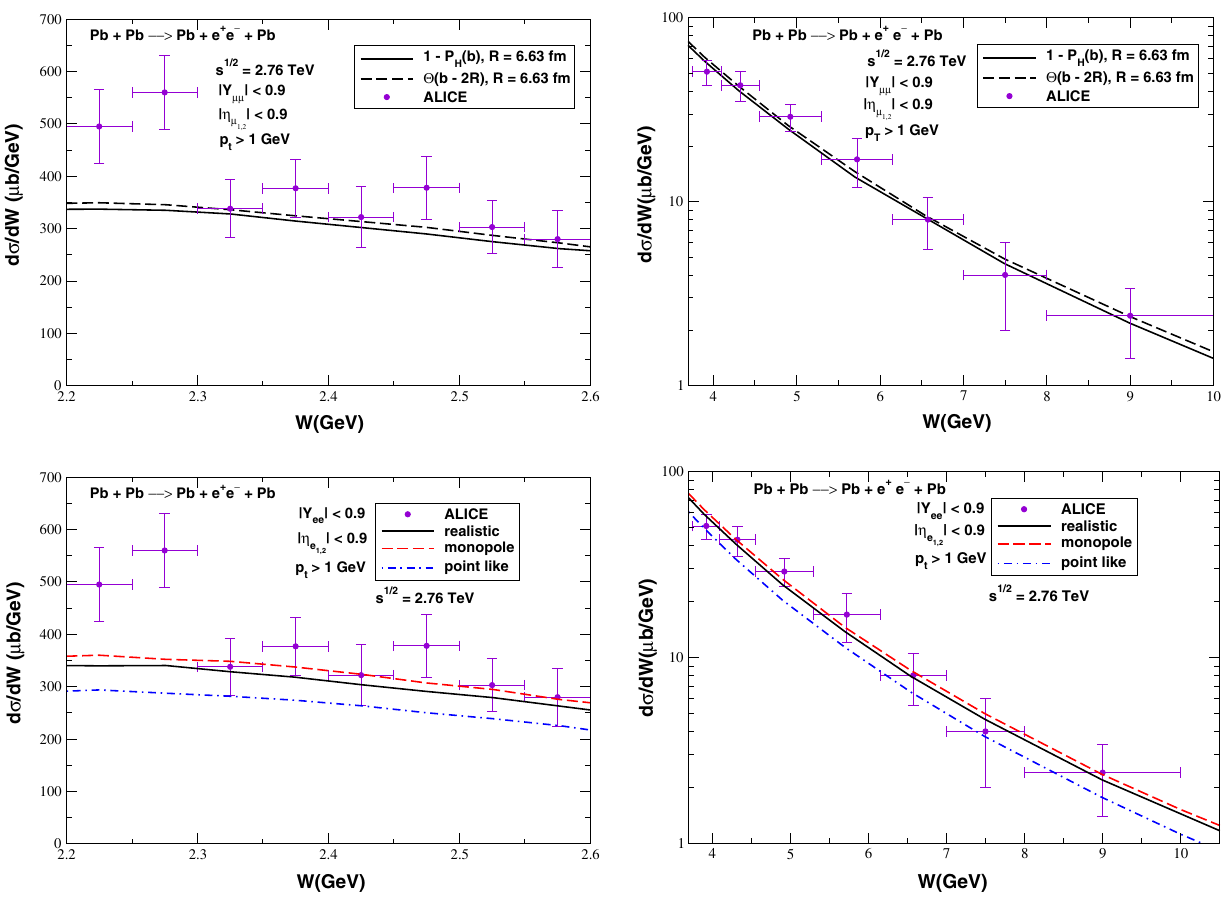
Fig. 5 Rapidityandinvariantmassdistributionsfortheexclusive e + e − production by γγ interactions in PbPb collisions at Experimental data from the ALICE Collaboration [2]. The predictions